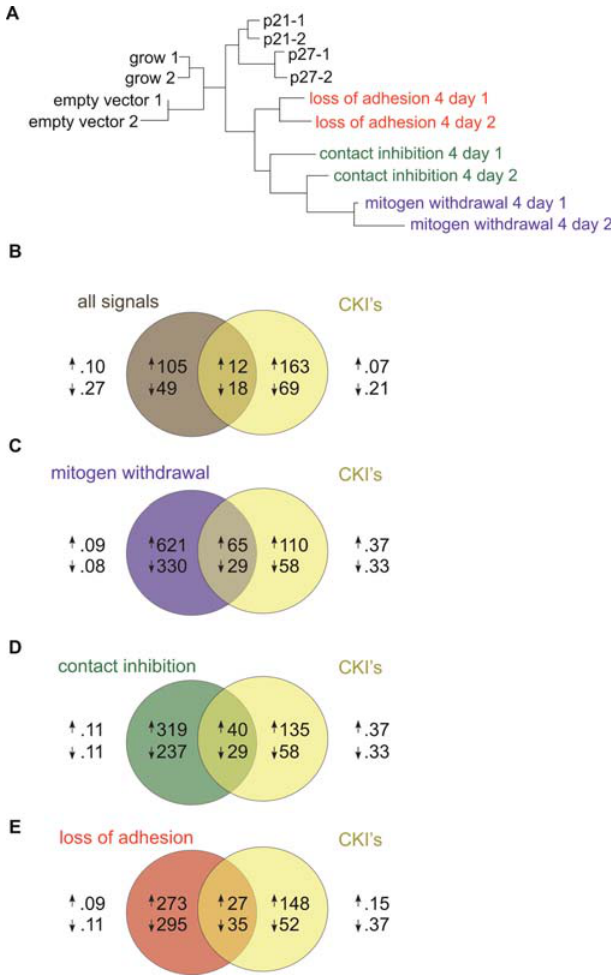
Figure 8. CKI Overexpression Does Not Closely Resemble the Quiescent State Induced by Any Extracellular Signal (A) Neighbor-joining tree of growing cells, cells arrested by extracellular signals for 4 d, cells transduced with an empty vector, and cells transduced with a CKI. Transcriptional distances were determined for all pairwise comparisons (Genechip suite 5.0), and neighbor-joining trees were drawn as described in Materials and Methods. (B–E) The overlap between genes regulated by CKI overexpression and genes consistently regulated by all signals (B), mitogen withdrawal (C), contact inhibition (D), or loss of adhesion (E) was determined. The number of regulated genes is shown within the circle. The fraction of regulated genes within the overlap area is provided outside the circles. Genes consistently downregulated by all three arrest signals were most likely to be regulated by CKI